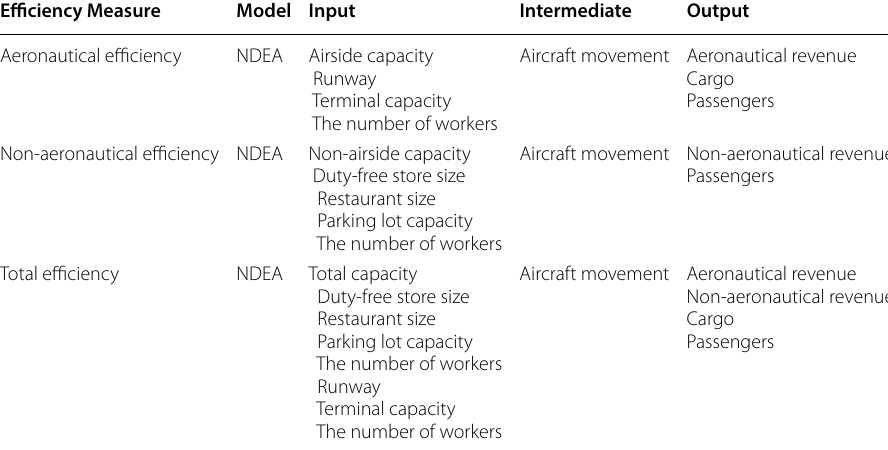
Table 1 Variables for each production process Efficiency